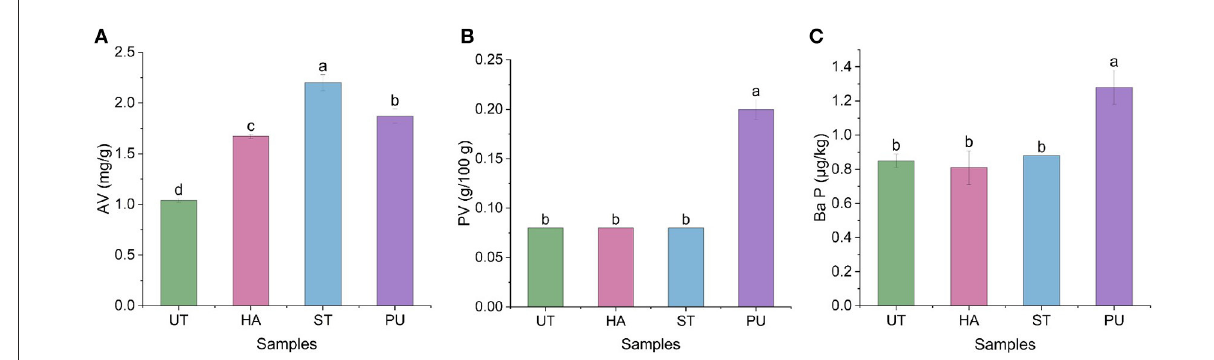
FIGURE5 The acid value (AV), peroxide value (PV), and Benzo(a)pyrene (Ba P) of camellia oil from untreated and HA, ST, PU pretreated camellia seeds. [ (A) AV, (B) PV, (C) Ba P]. Bars with no letter in common are significant different ( P <